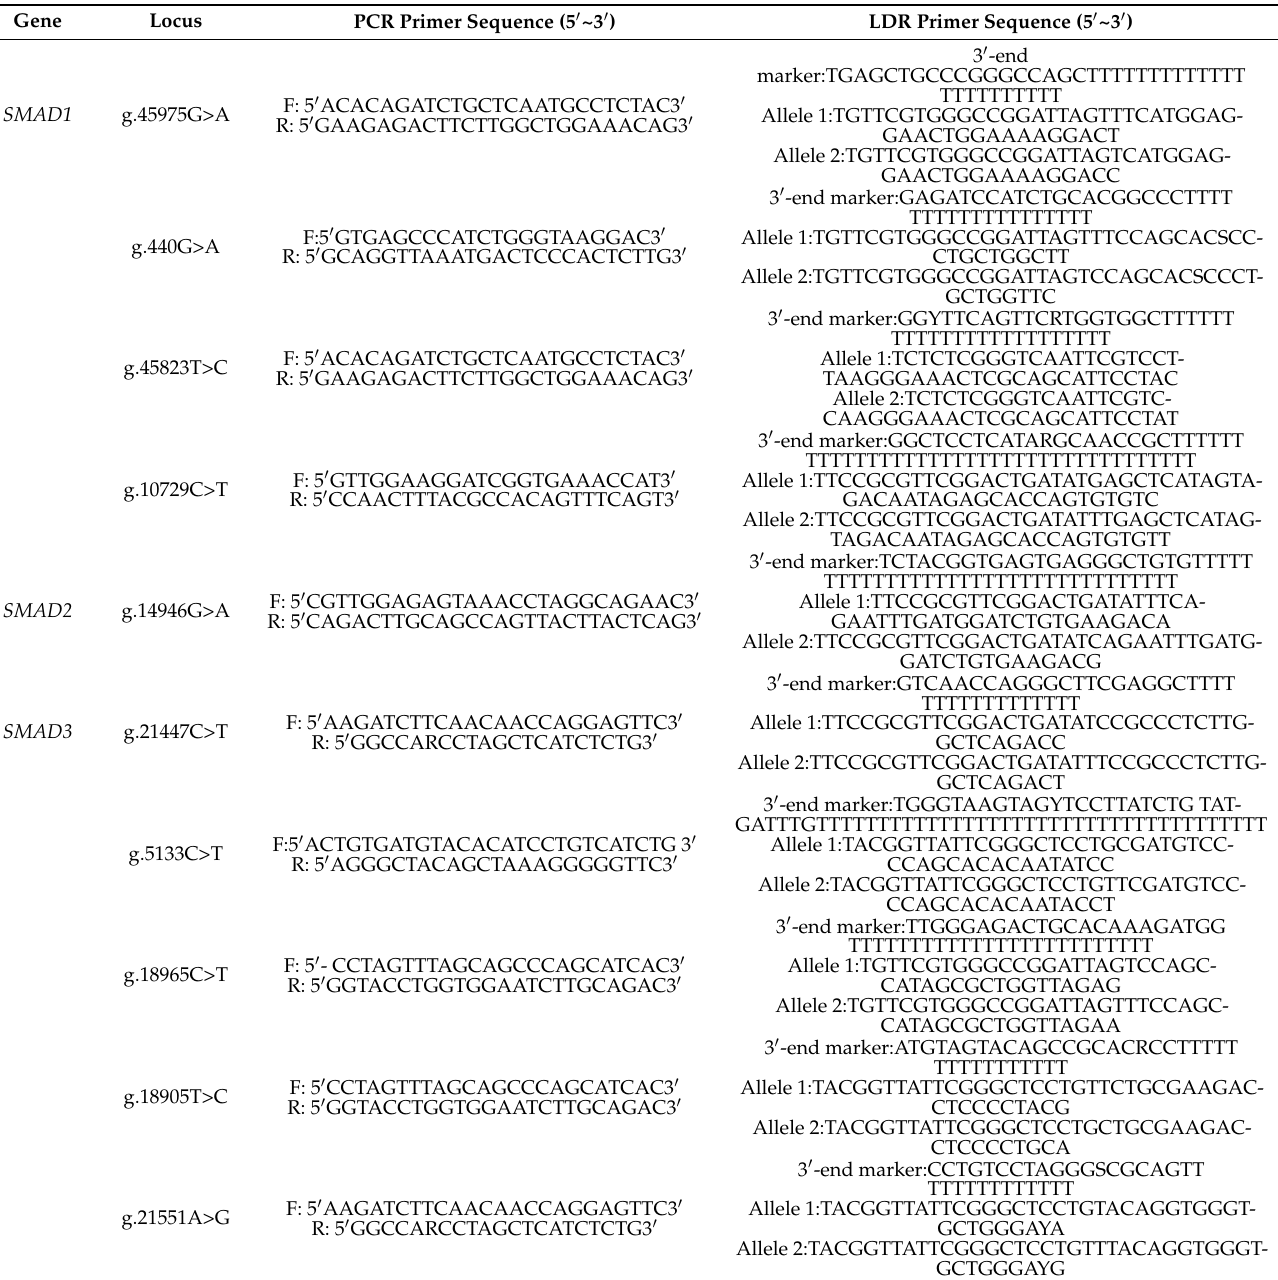
Table 2. iMLDR genotyping